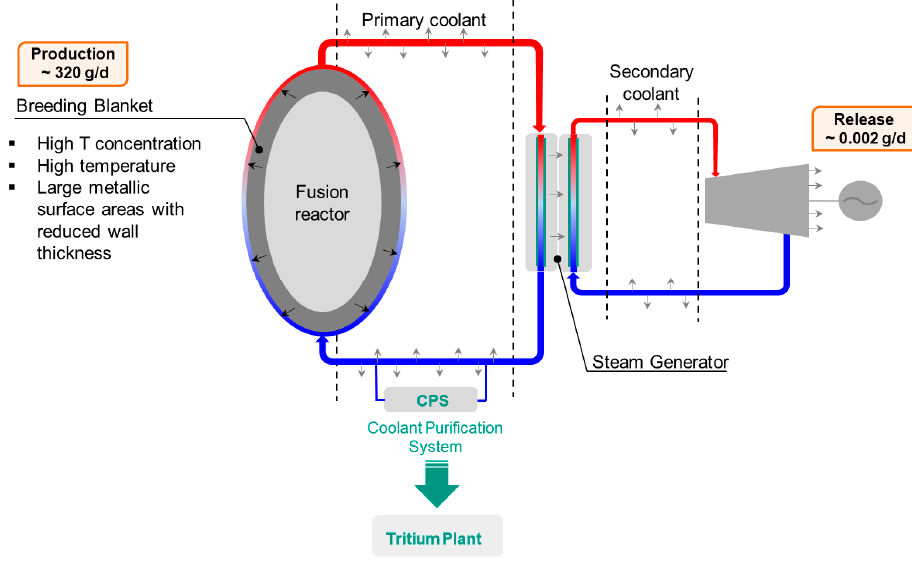
Figure 1. Simplified scheme of the coolant loop and Coolant Purification System (CPS) used for tritium mass balance.